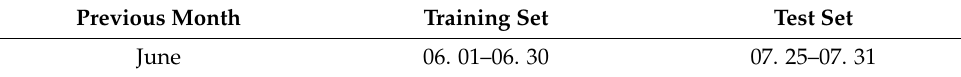
Table 4. Training set and test set of the GBM model trained by the previous